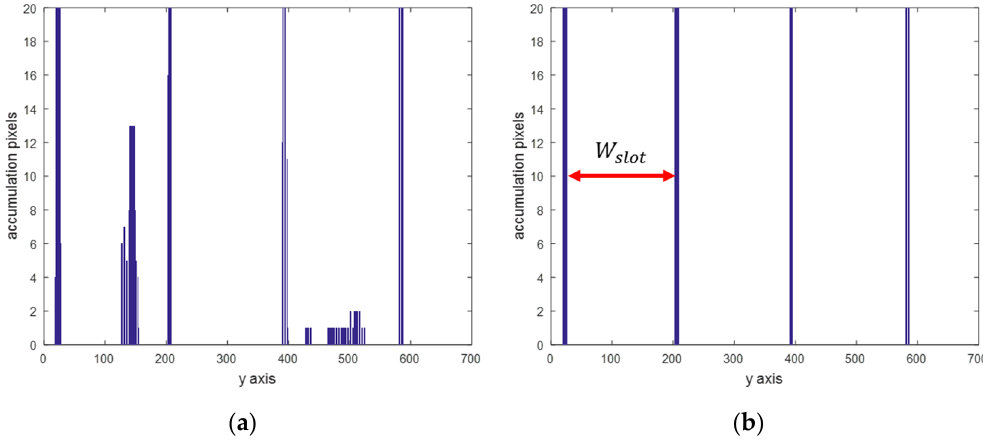
Figure 10. Perpendicular parking. ( a ) Scanned distribution; ( b ) Distribution after filtering.